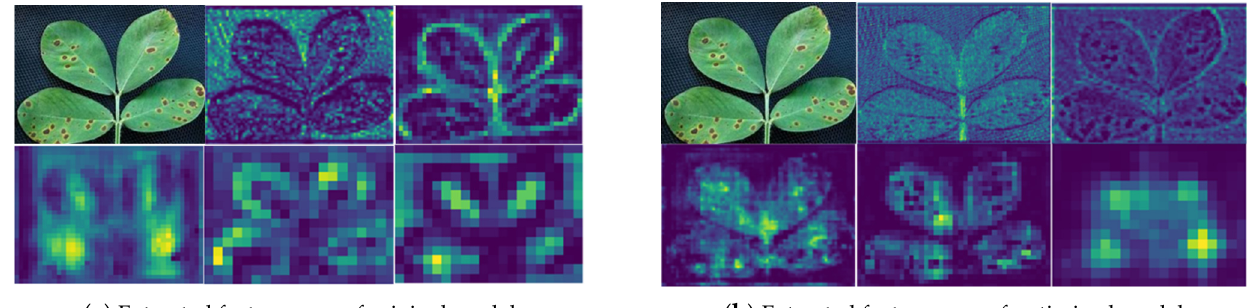
Figure 14. Extracted feature map of original model ( a ) and the optimized model ( b ).